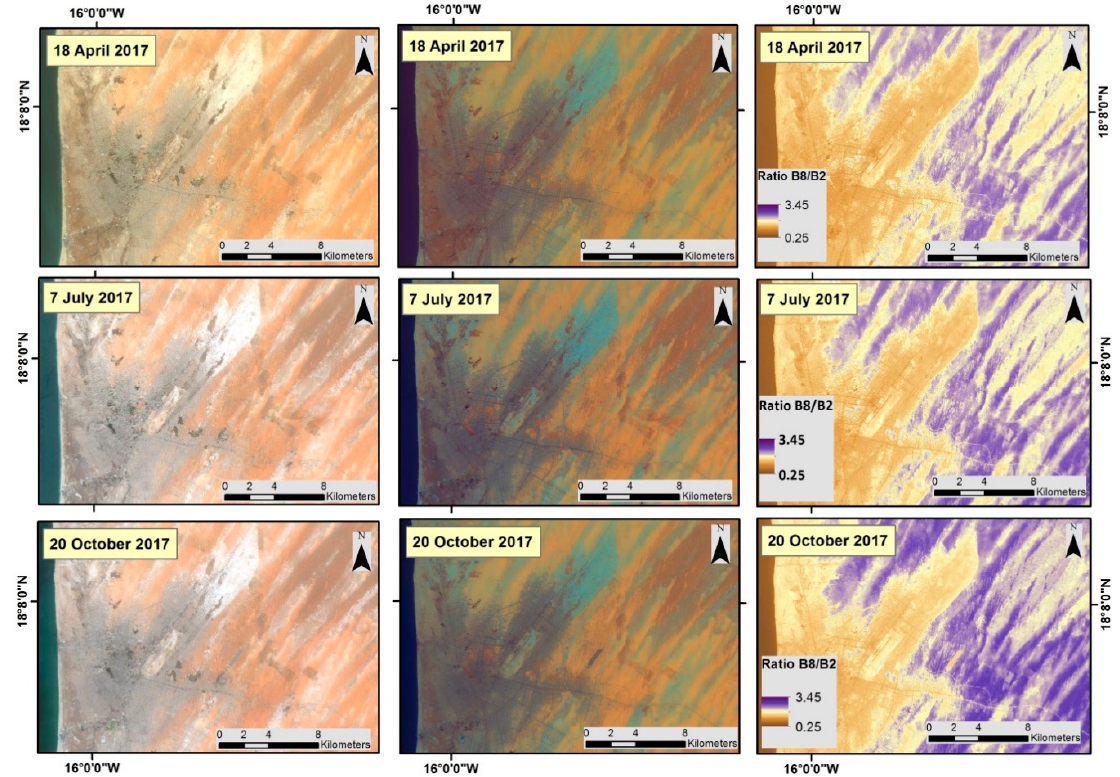
Figure 8. Natural color composite ( left ), false composite color ( center ) and B8/B2 ratio ( right ) images at Nouakchott to assess sand mobility.